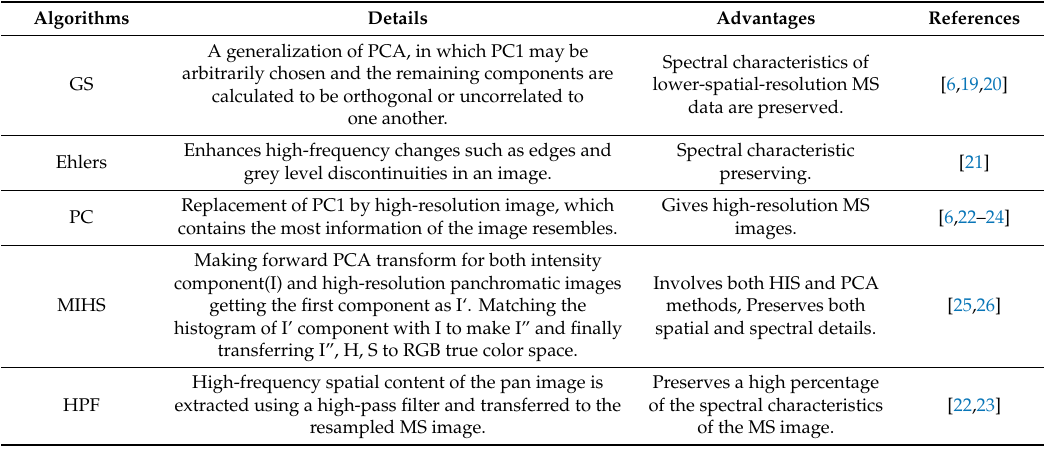
Table 2. Di ff erent image fusion algorithms for the